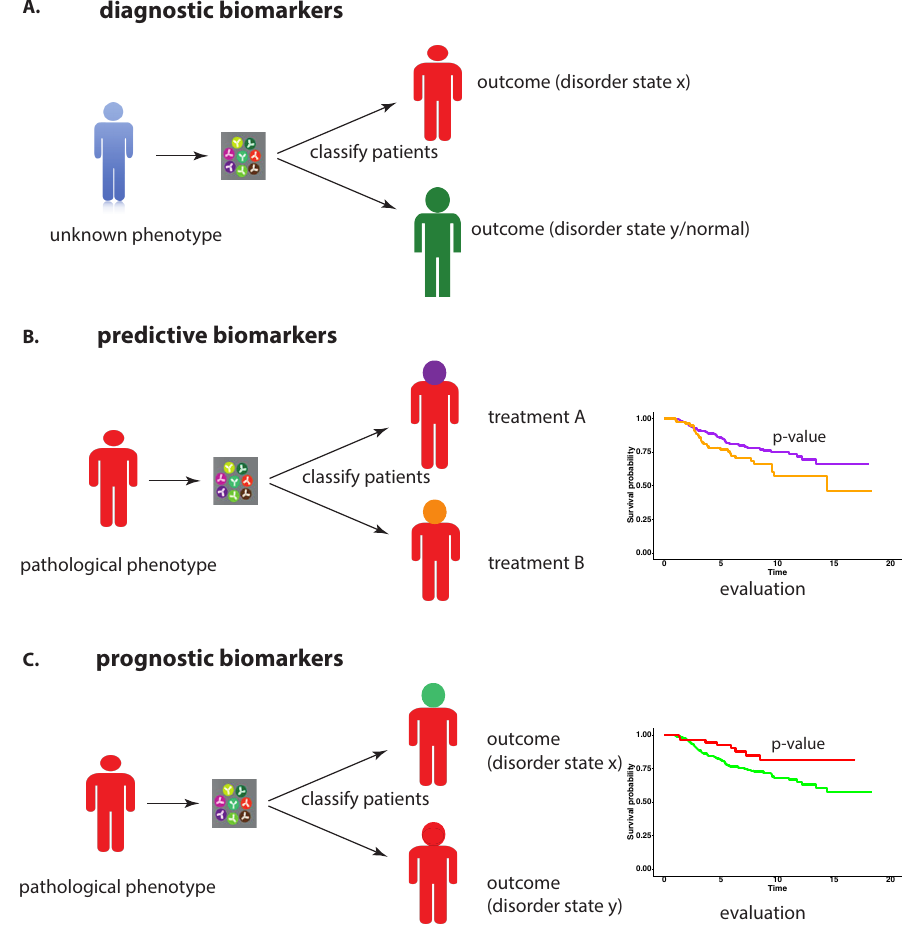
Figure 1. An idealized overview of three types of biomarkers and their application purpose. A: diagnostic biomarkers, B: predictive biomarkers, C: prognostic